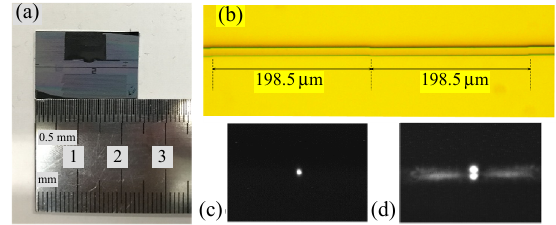
Fig. 5 Sample pictures and test spot: (a) fabricated sample picture, (b) diagram of LWGs under the microscope, and (c) and (d) are the test spot results of the E 11 mode and the E 21 mode, respectively.